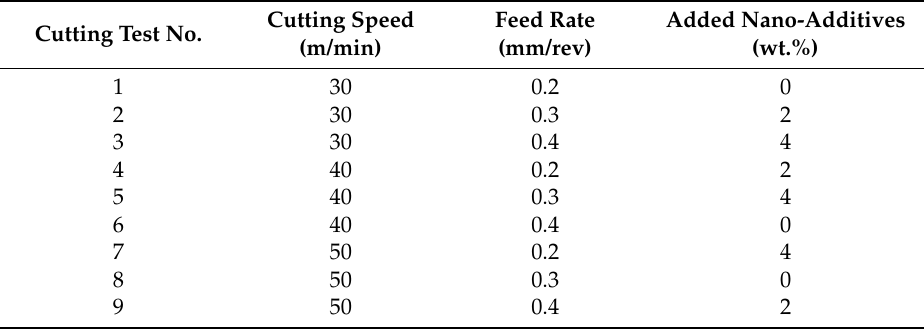
Table 2. L9OA used in experimentation